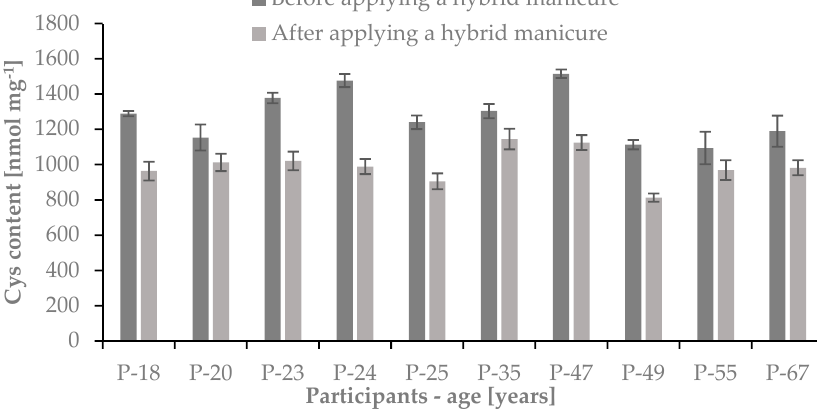
Figure 8. The Cys content in the nail plates of studied women before and after the use of hybrid manicure; n = 3.